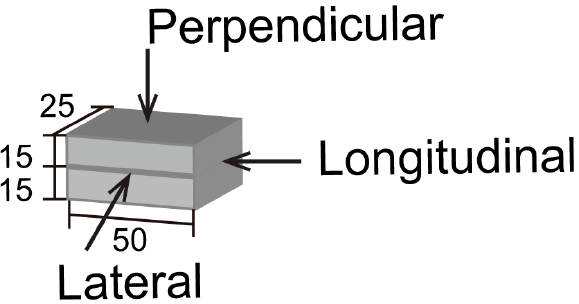
Figure 4. The load directions in measuring the compressive strength of the printed specimens.